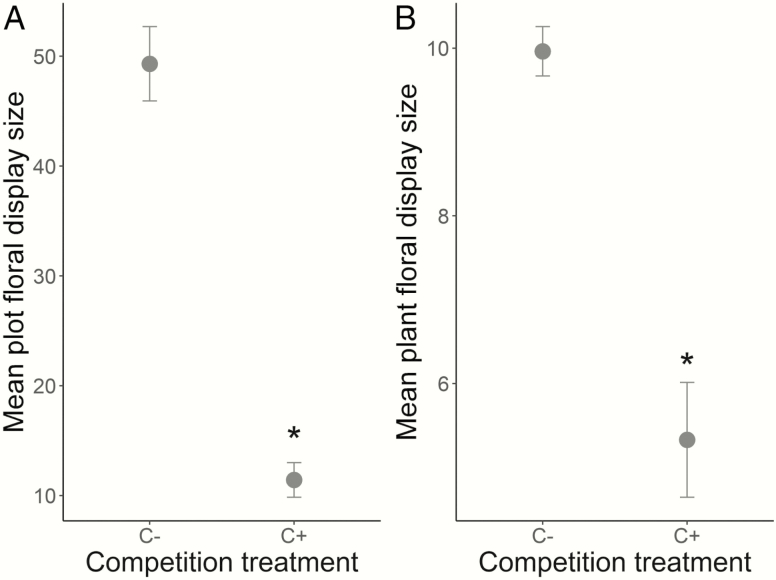
Mean floral display size (± SE) of S. alba without (C−) and with competition (C+) at (A) the plot and (B) the plant level. A star represents a significant difference (Pplot = 6.06e-3, Pplant = 5.28e-15, GLMM).